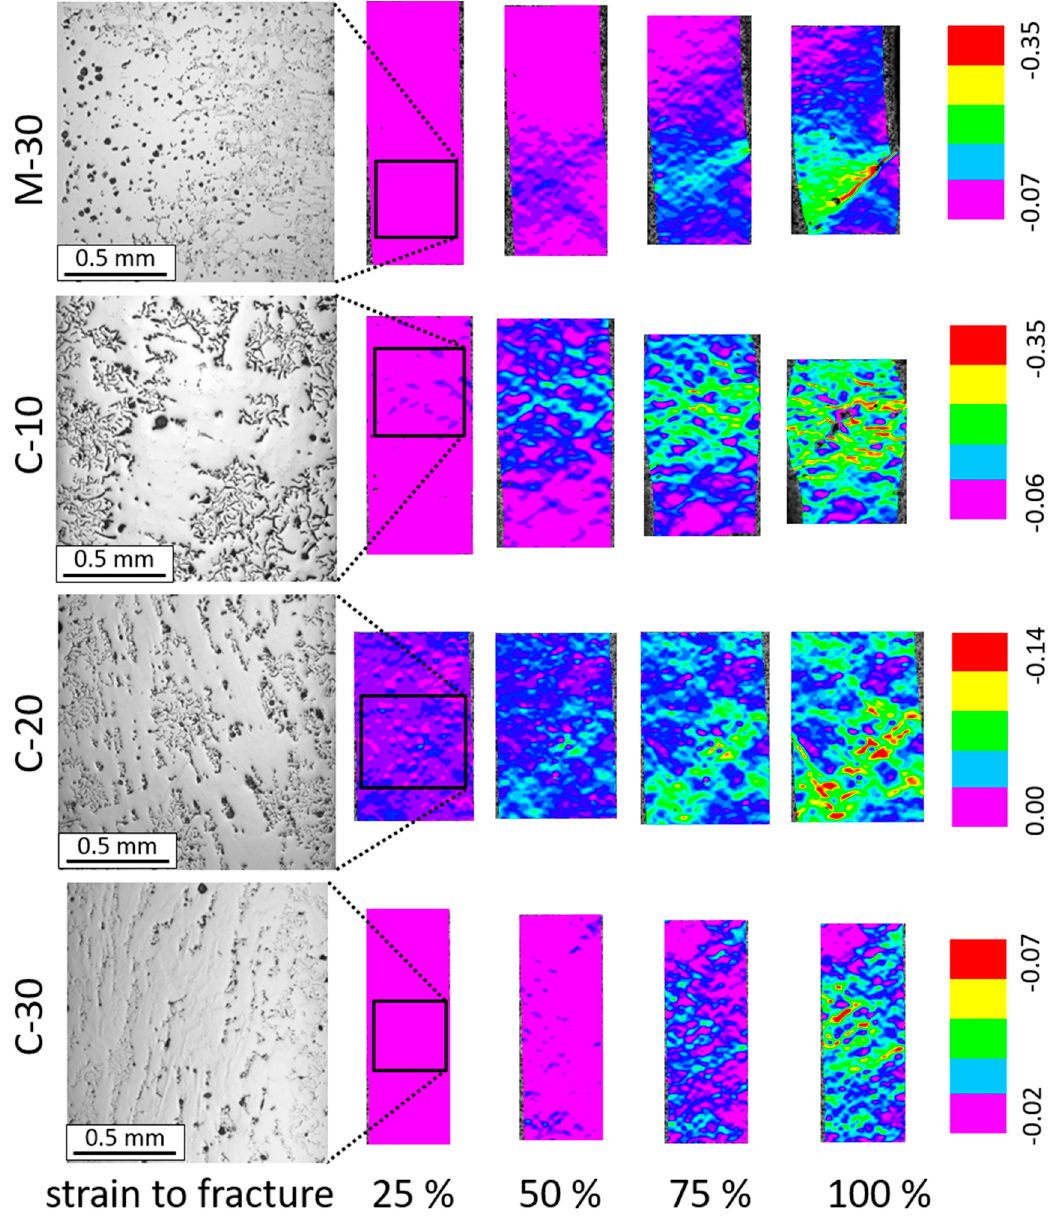
Figure 4. Local strain distribution of M-30, C-10, C-20 and C-30 at 25%, 50%, 75% and 100% of their respective total compression. The optical microscope images show the region of the specimen where strain localization and failure initiated.